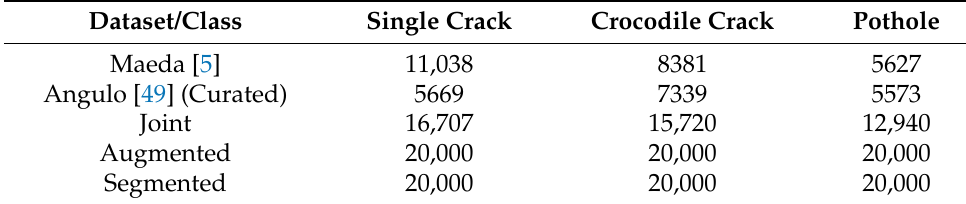
Table 4. Road damage categories considered in the project and number of instances per